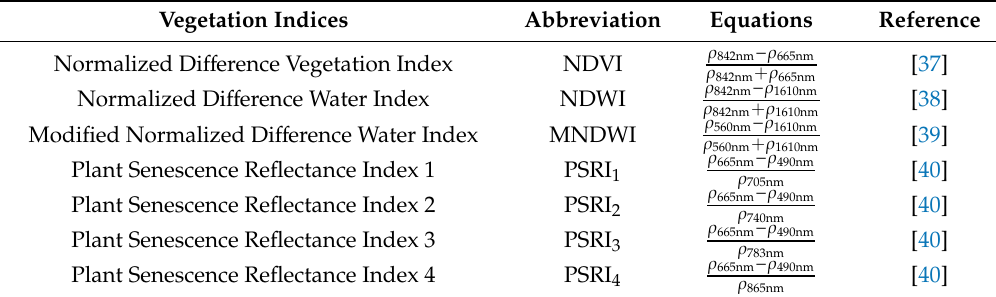
Table 3. Vegetation indices (VI) derived from Sentinel-2 imagery. ρ stands for Top-of Atmosphere reflectance at a specified